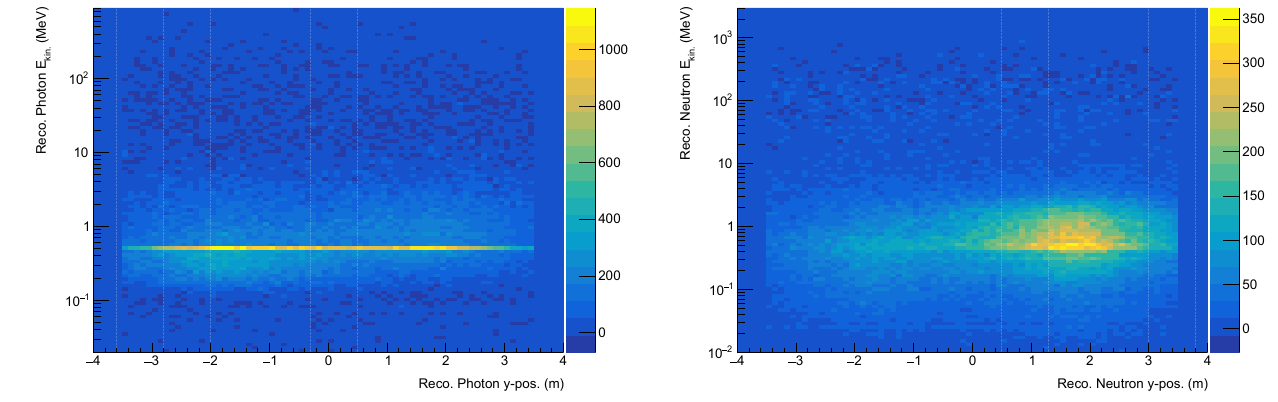
Figure 7. The distribution of the kinetic energy E kin . as a function of the y -position of the reconstructed photons ( left column ) and neutrons ( right column ) in the sidewise detector planes. The materials analyzed are Magnesium and Cesium ( upper row ), Chromium and Ytterbium ( middle row ), as well as Molybdenum and Lead ( bottom row ). The hits from the empty container are subtracted.